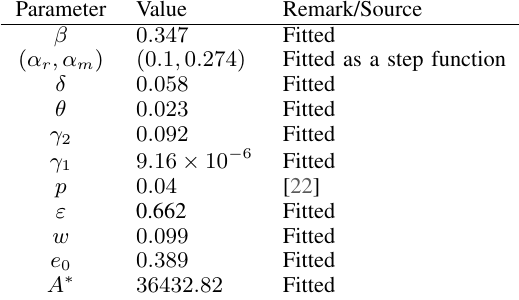
Table IV: Parameter values found by